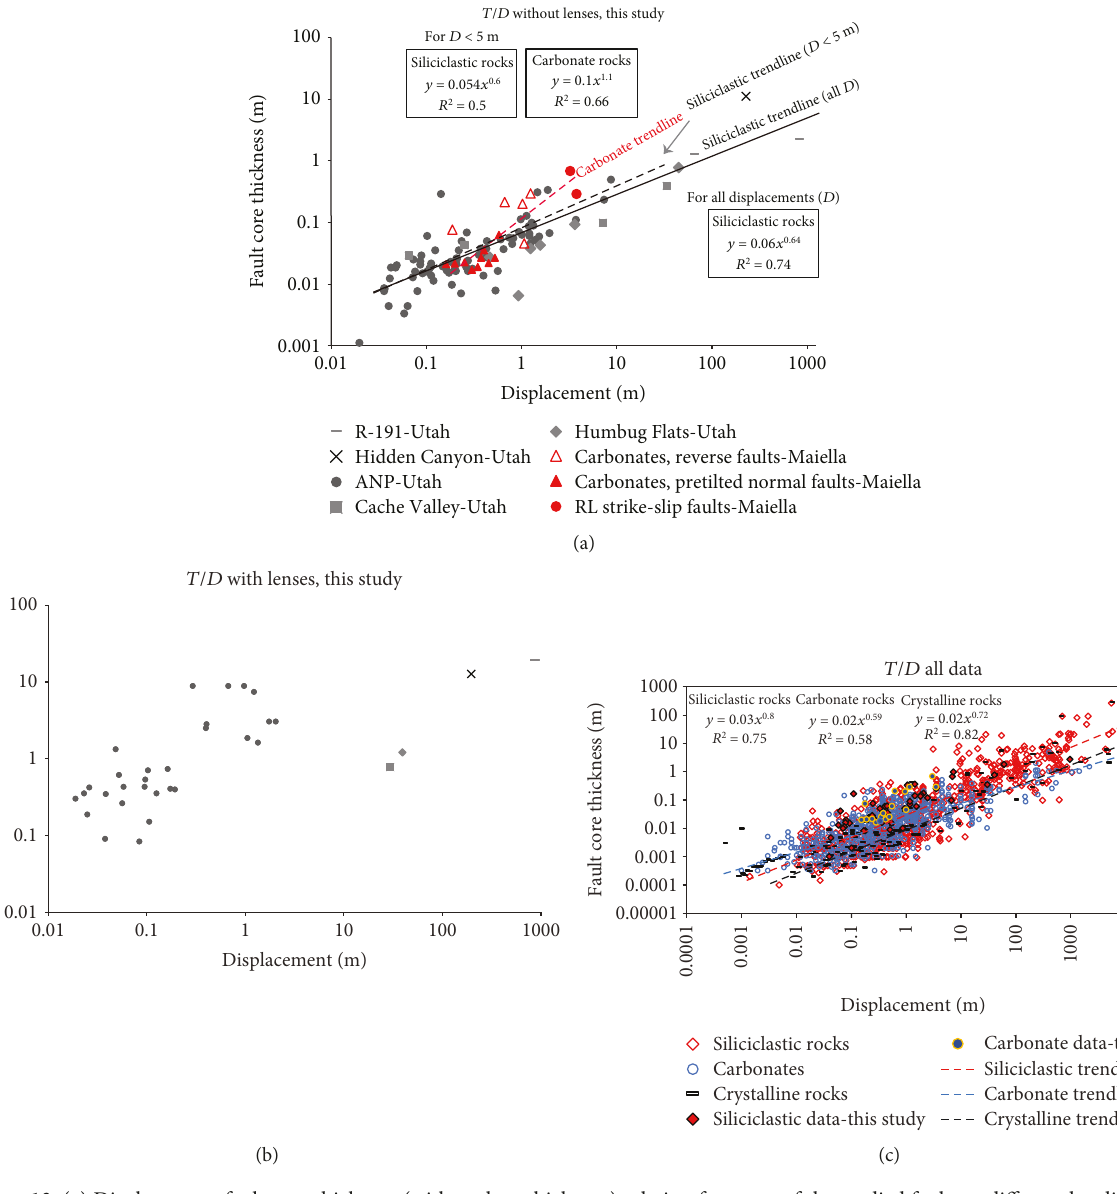
Figure 13: (a) Displacement-fault core thickness (without lens thickness) relation for some of the studied faults at di ff erent localities in this work. (b) Displacement-fault core thickness (with lens thickness) relation for some of the studied faults at di ff erent localities in Utah. (c) Displacement-fault core thickness relationship for a compiled database from published data and this study (without lens thickness). Note that three power laws fi t to the data from faults in siliciclastic, carbonate, and crystalline rocks. The references used for this study are included in Table